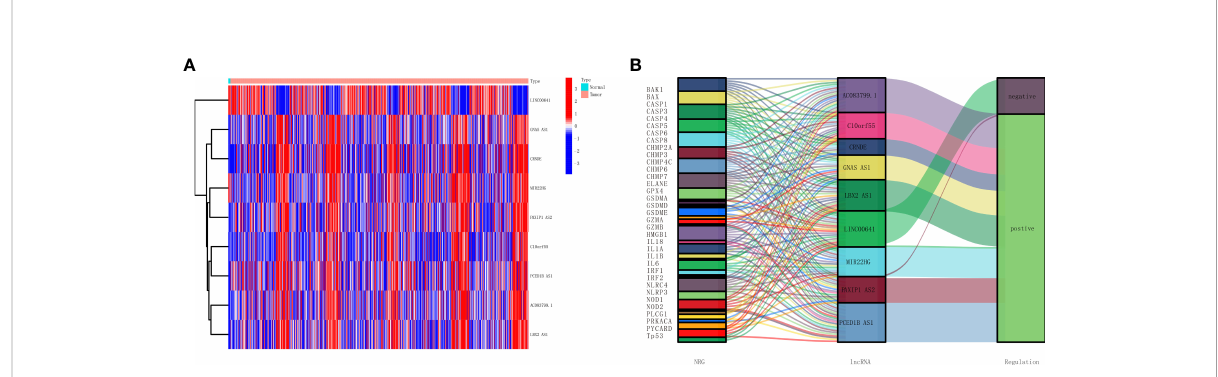
FIGURE 2 Establishment of a necroptosis-related lncRNAs prognostic model. (A) Heatmap presents the nine necroptosis-related lncRNAs with prognostic value in TCGA. (B) Sankey diagrams show the necroptosis-related mRNAs and nine necroptosis-related lncRNAs with prognostic values in TCGA. lncRNAs, long non-coding RNAs; TCGA, The Cancer Genome Atlas.